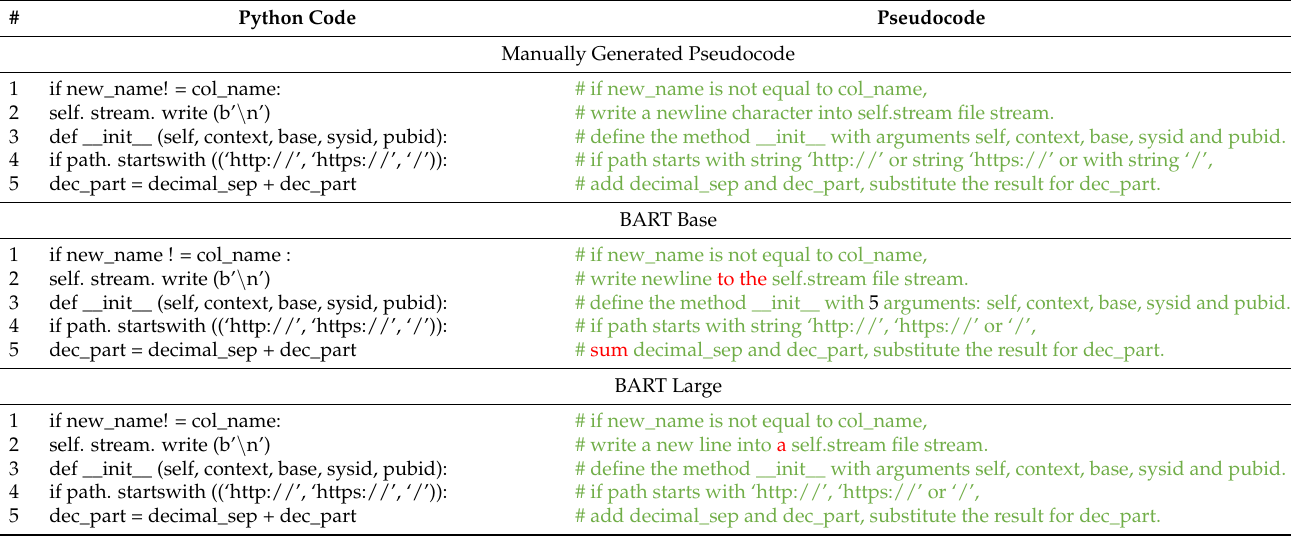
Table 3. The output of BART base and BART large for Django samples.